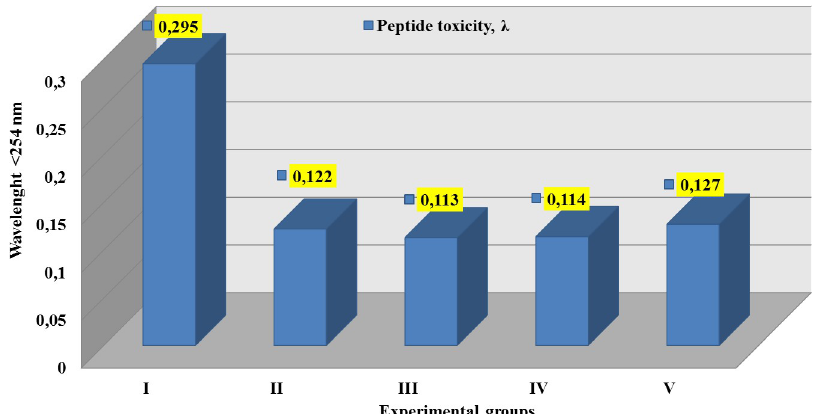
Fig 4. Results of peptide toxicity of each diet. Values are given as mean ± SD for a total of 50 animals. Control group (I) - 0.295 nm, Curd mass (II)– 0.122 nm, Curd mass with flaxseed flour (III)– 0.113 nm, curd mass with celery root powder (IV) - 0.114 nm, Curd mass with bee bread (V)– 0.127 nm. There were decreasing in PT of all samples compared to group I. Groups II and III results presented a lower PT with some fluctuation compared to other group results. The group III results higher than II to 0.005 nm. The group I shows superior results, but lower than main PT requirements.